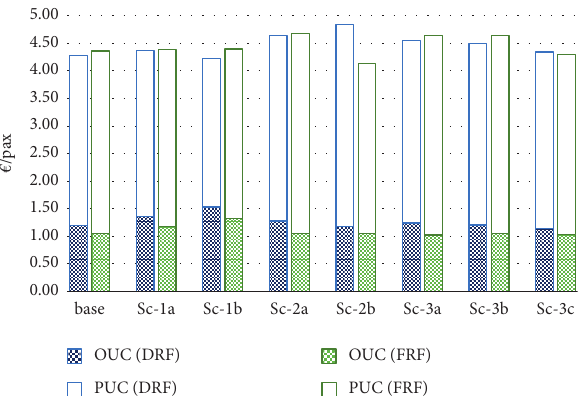
Figure 11: Comparison between the DRF and the FRF in different scenarios (for result interpretation; PUC � passenger unit cost; OUC � operator unit cost).